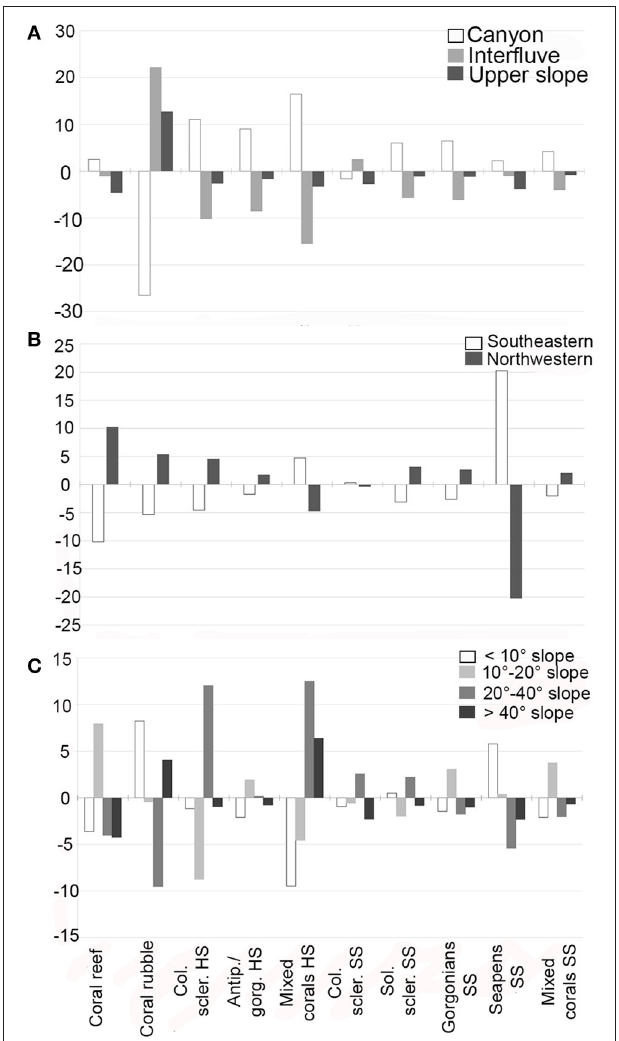
FIGURE 9 | Standard residuals of chi-square tests of the frequency of images of each habitat on (A) the different canyon morphologies, (B) the southeastern and northwestern flank of the canyon/interfluves, and (C) the four slope intervals of the canyon/interfluves flank. If the residuals are less than − 2, the observed frequency is less than the expected frequency according to a random distribution. If the residual is greater than 2, the observed frequency is greater than the expected frequency. The lower ( < − 2) or higher ( > 2) the residual value is, the stronger is the contribution of this category to the observed distribution. Col. scler. HS, Colonial scleractinians HS; Antip./Gorg. HS, Antipatharians/gorgonians HS; Col. scler. SS, Colonial scleractinians SS; Sol. Scler. SS, Solitary scleractinians